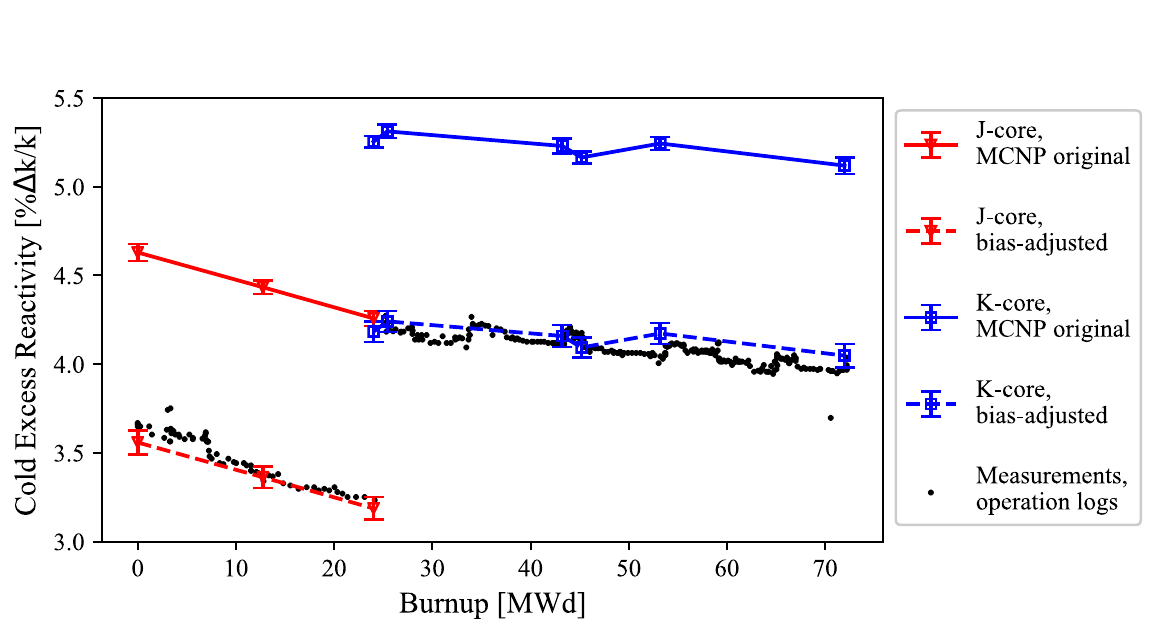
Figure 4: Comparison of cold excess reactivity measurements from operation logs with original and bias-adjusted simulation results by